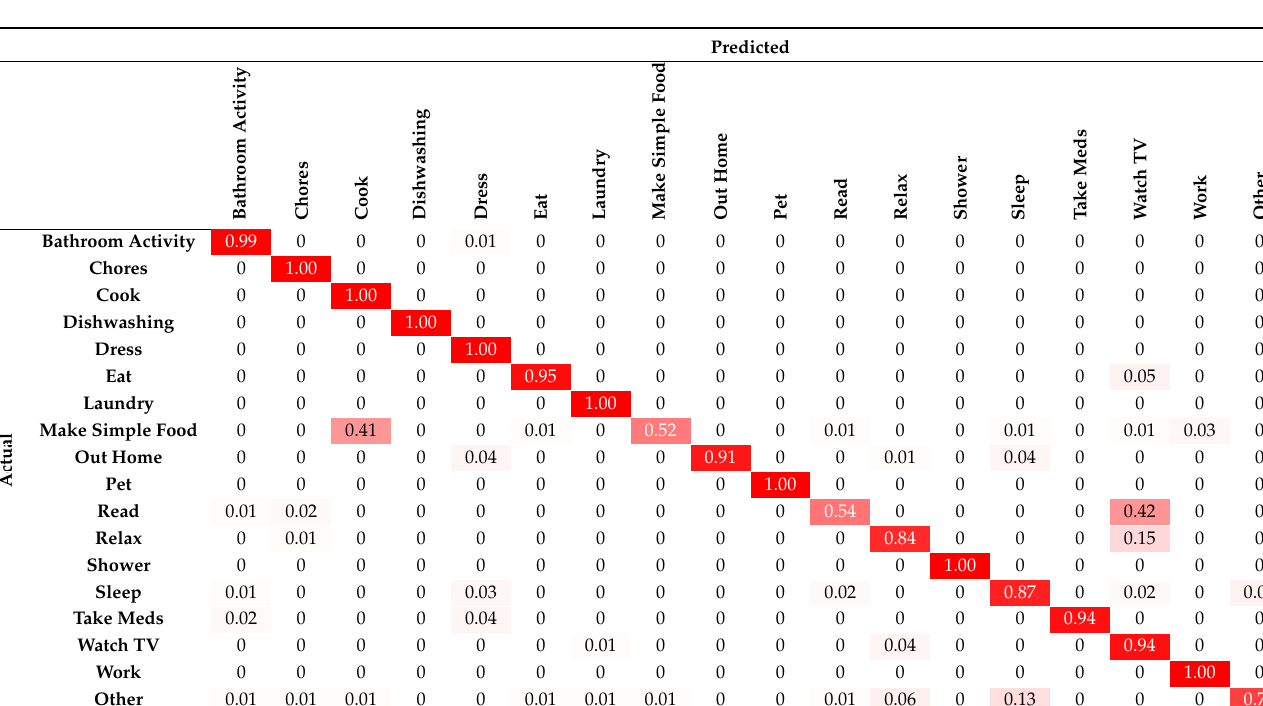
Table 8. Neural network User 2: Confusion